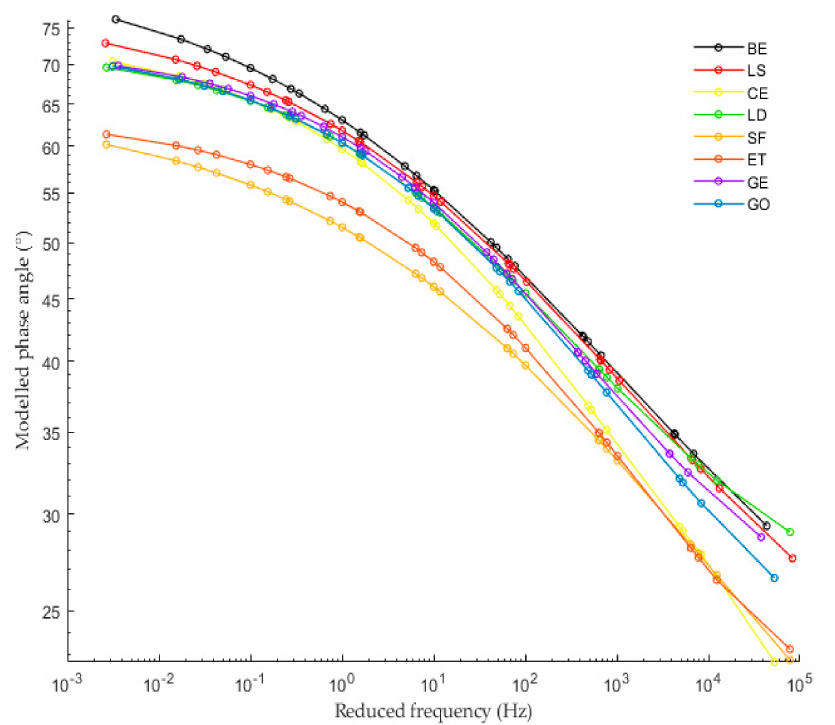
Figure 8. Modeled phase angle master curves of Bitumen Emulsion (BE) and CBE mastic at a reference temperature of 20 ◦